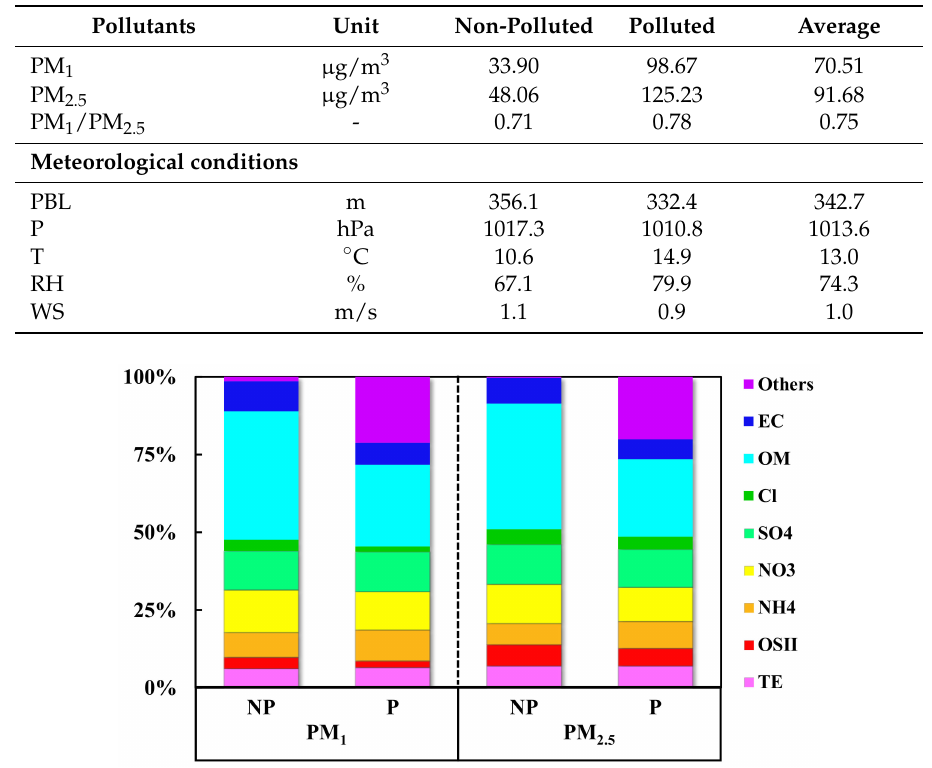
Figure 5. The mass fractions of chemical components for different pollution levels (NP: non-polluted; P: polluted; OSII: other soluble inorganic ions; PBL: planetary boundary layer; RH: relative humidity; WS: wind